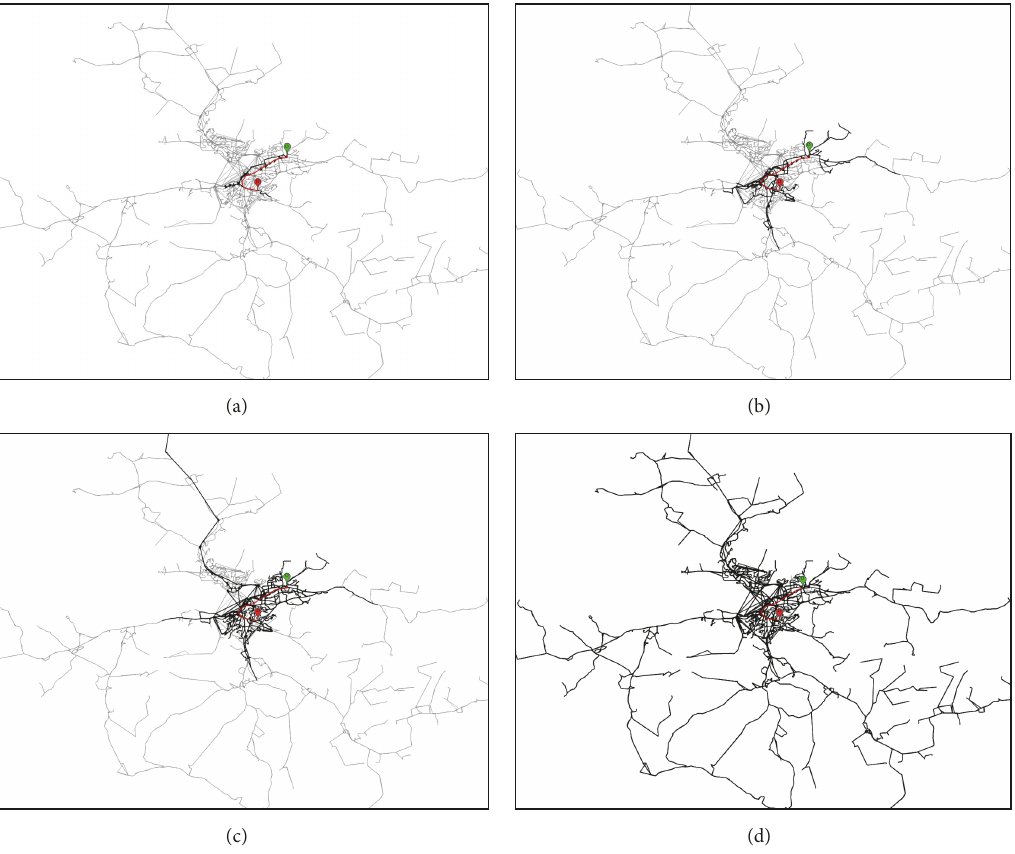
Figure 9: Visualization of search spaces for Stages 2–5. The black lines indicate the traversed edges; the red lines show the optimal path. Table 2: Average runtime (sec) and result count for stages of GPFA